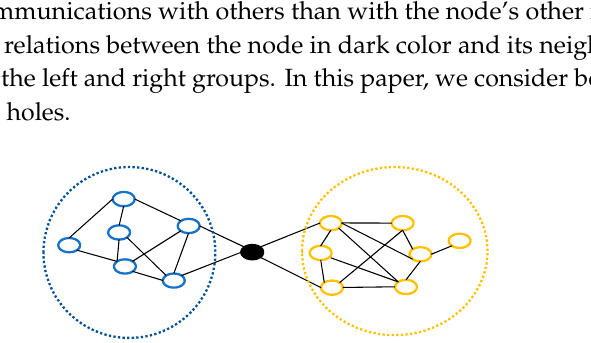
Figure 2. Case of greater conductance. The node in the dark color’s neighbor community has greater conductance than its neighbors.